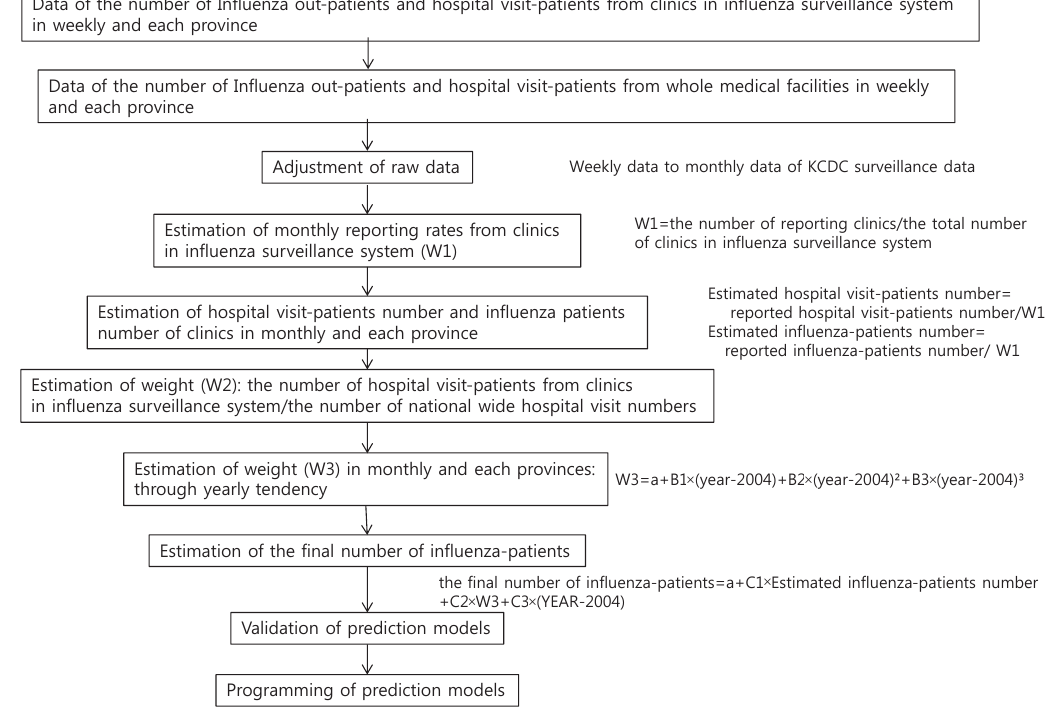
Figure 1. Procedure of model development to calculate influenza incidence. KCDC, Korea Centers for Disease Control and Prevention; a is constant, B1, B2, B3, C1, C2, and C3 are coefficients from this regression model. From Roh YK. Modeling the national pandemic influenza cases and inpatients of pneumonia in Korea. Osong: Korea Centers for Disease Control and Prevention; 2011